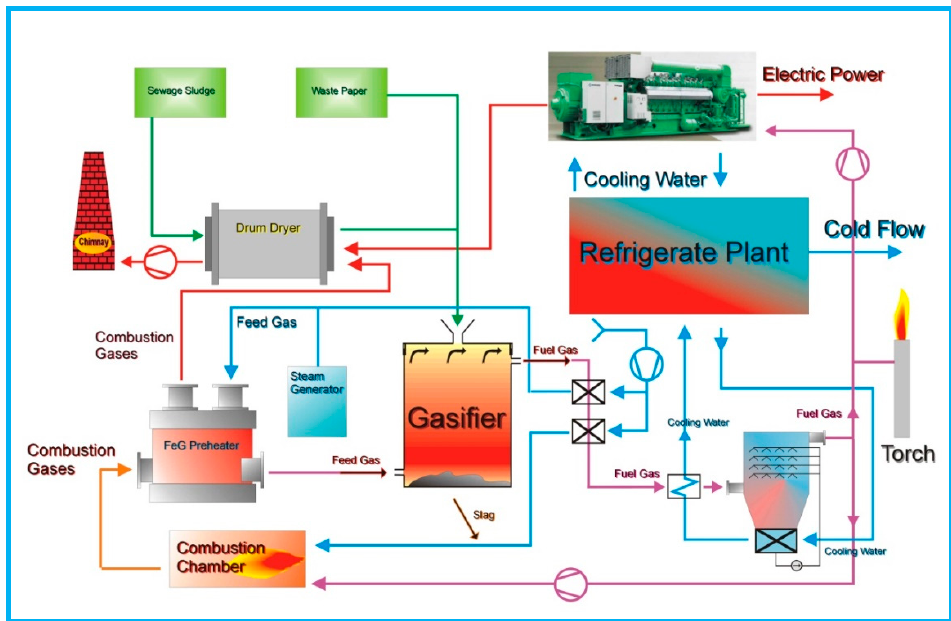
Figure 17. A proposal of a semi-industrial high-temperature biomass gasification installation for power generation design by KTH/GUT research group. The key component of the system is the FeG Preheater which produces a high-temperature feed gas.